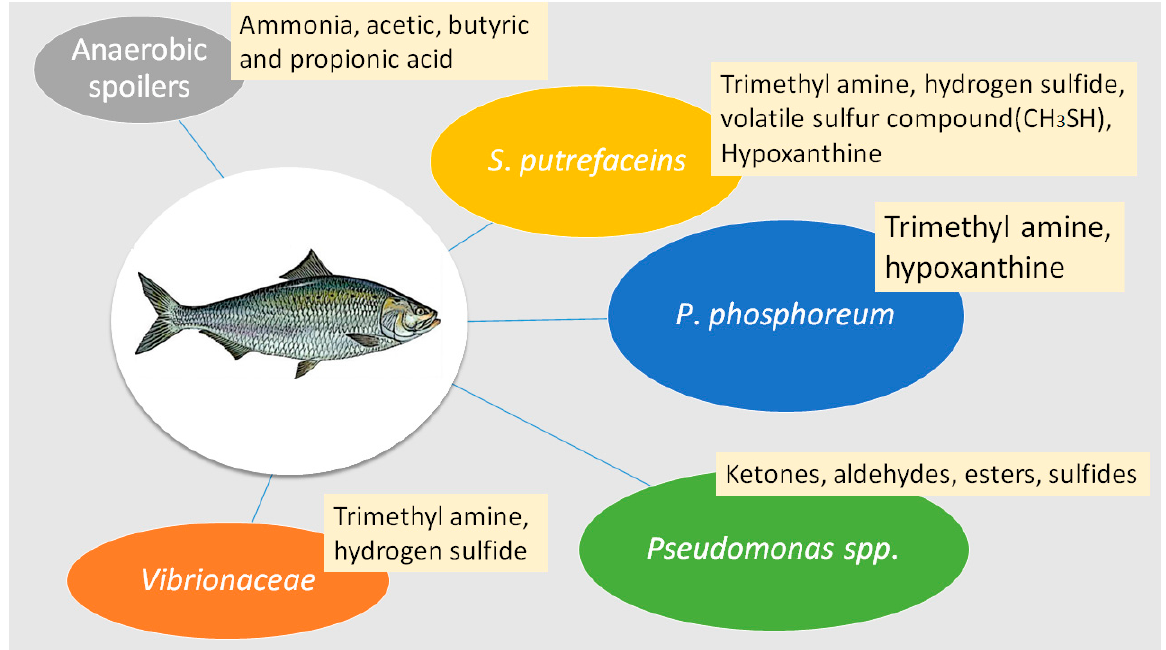
Figure 1. Typical types of spoilage bacteria and typical compounds found during fish